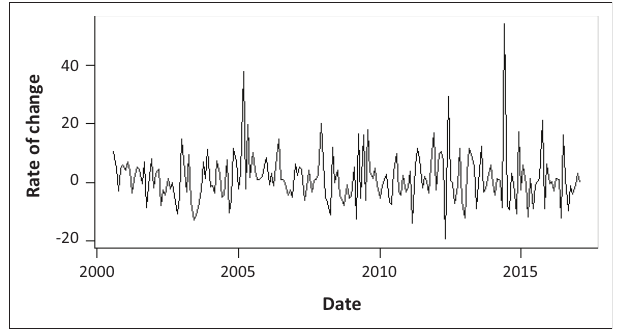
FIGURE 15: Kenya – Movement of the exchange market pressure index (August 2000–February 2017).